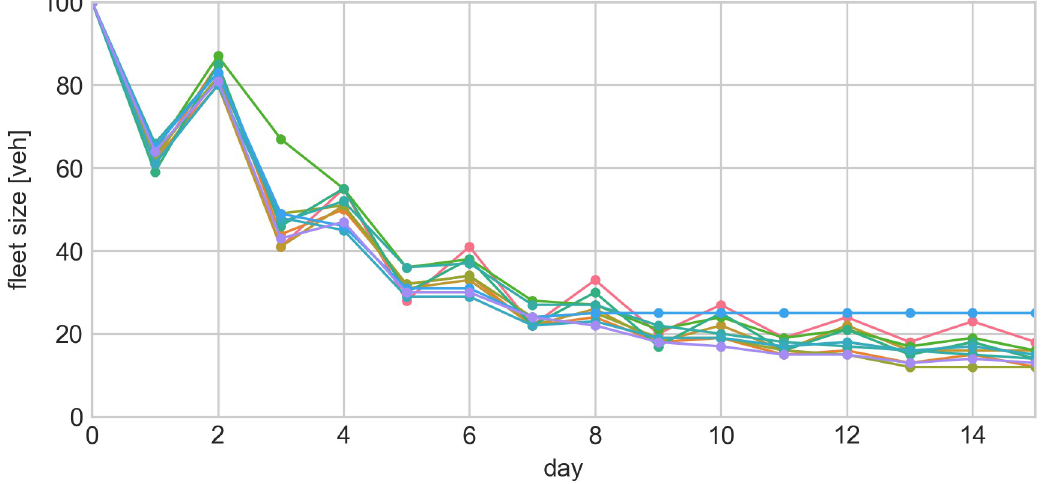
Fig 7. Fleet size evolution for 10 non-deterministic replications of driver learning behaviour. Drivers make daily decisions to opt-out or stay in the system based on previous experience and expected outcomes.